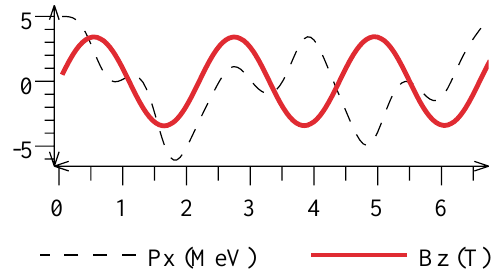
FIG. 3. (Color) p x (MeV (cid:3) c ) vs z (m) in three cells of the FOFO cooling channel. The transverse momentum changes at the lo- cation of each field reversal, which gives rise to the incoherence of the Larmor motion, shown in the preceding figure.